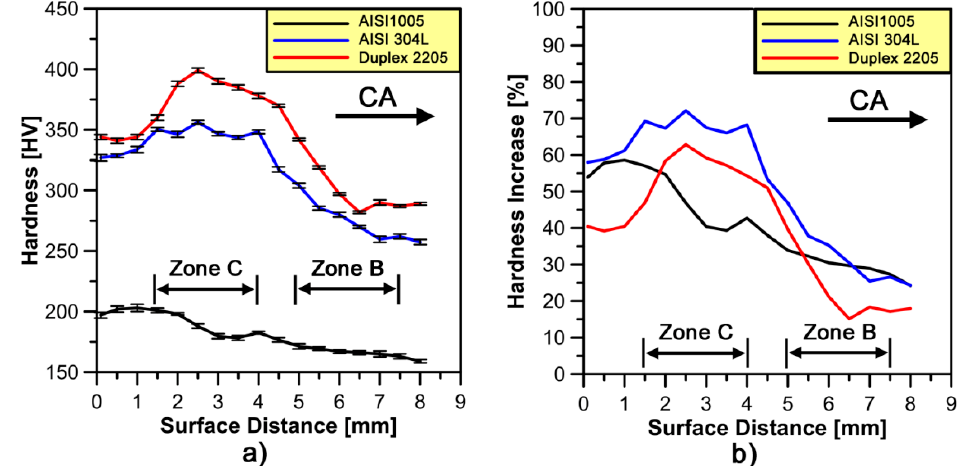
Figure 4. Average: ( a ) micro-hardness profiles; and ( b ) trends of micro-hardness increase rate as a function of distance along the compression axis (CA). Data refer to the investigated steels.